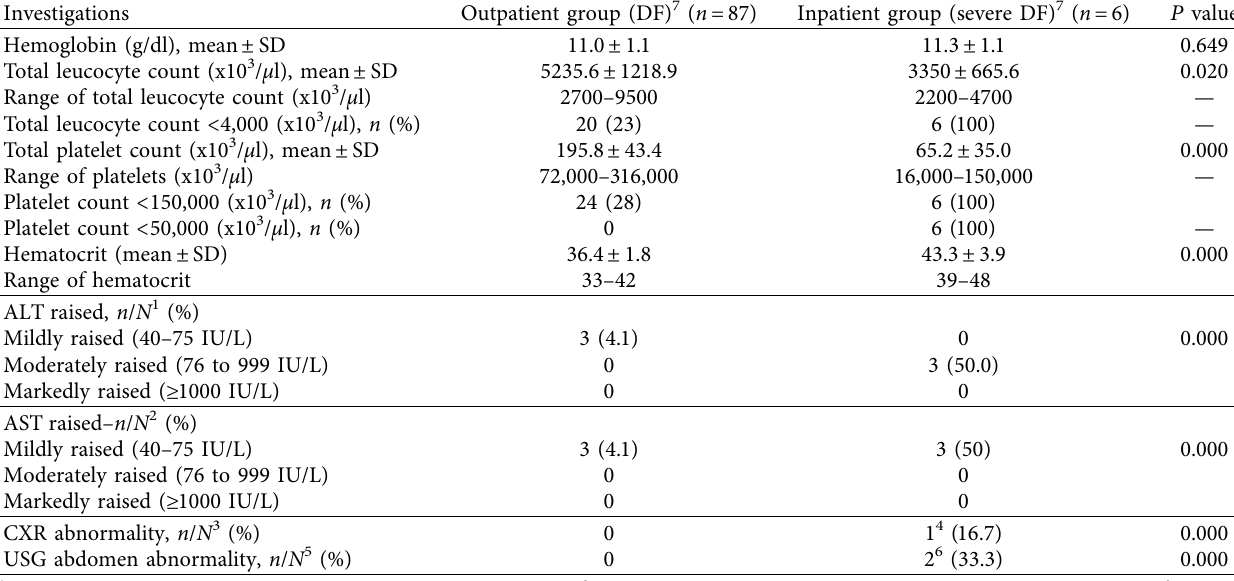
Table 2: Comparison of baseline laboratory investigations of the outpatient and inpatient groups at initial presentation. Investigations